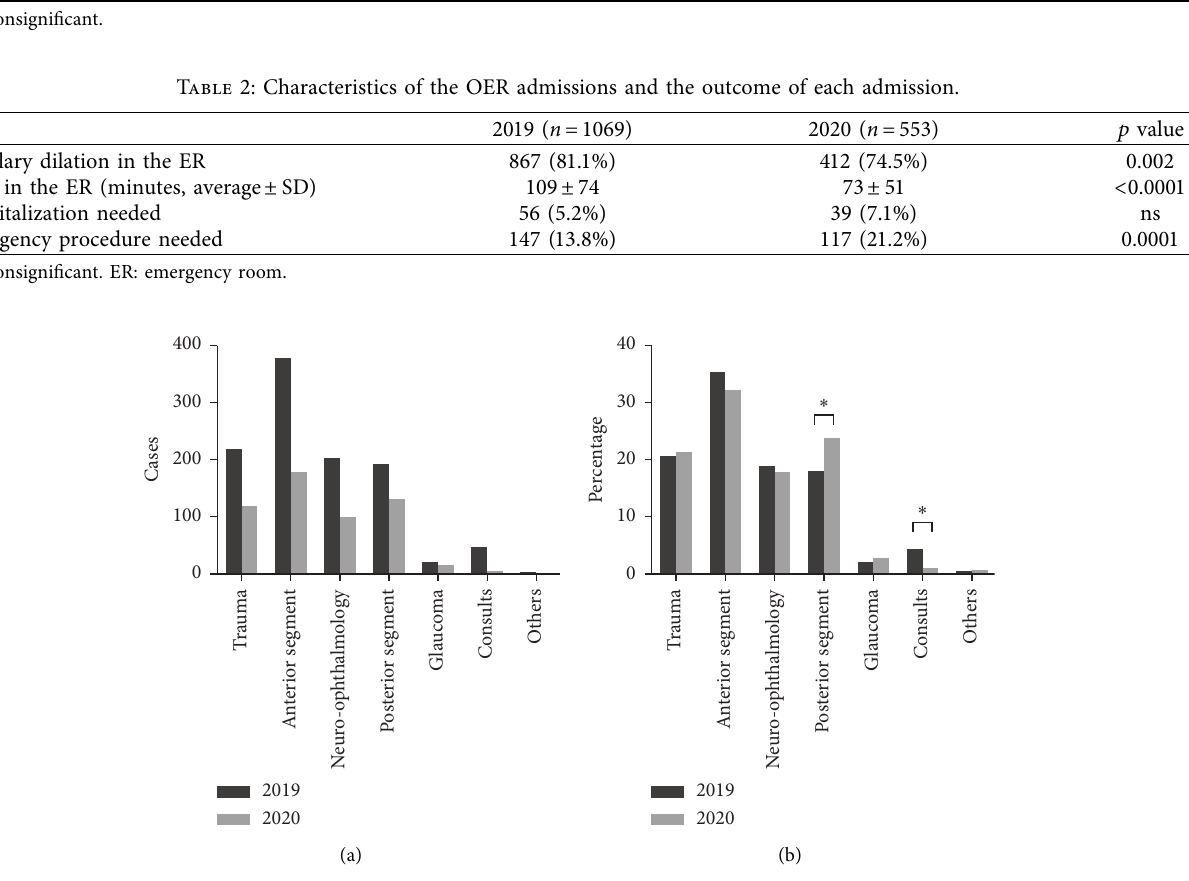
Figure 1: The distribution of patients grouped by diagnosis in the OER during the COVID-19 pandemic (2020) and in the previous year (2019). (a) The number of patients. (b) The percentage of